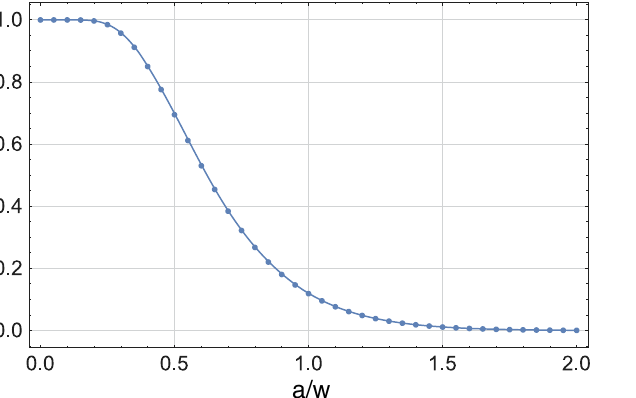
FIG. 4. Dependence on the waveguide relative width a=w of the normalized longitudinal electric field E rectangular waveguide. Solid curve: dependence of formula (59) on a=w normalized by − 2 Q decomposition method [14] and also normalized by − 2 Q